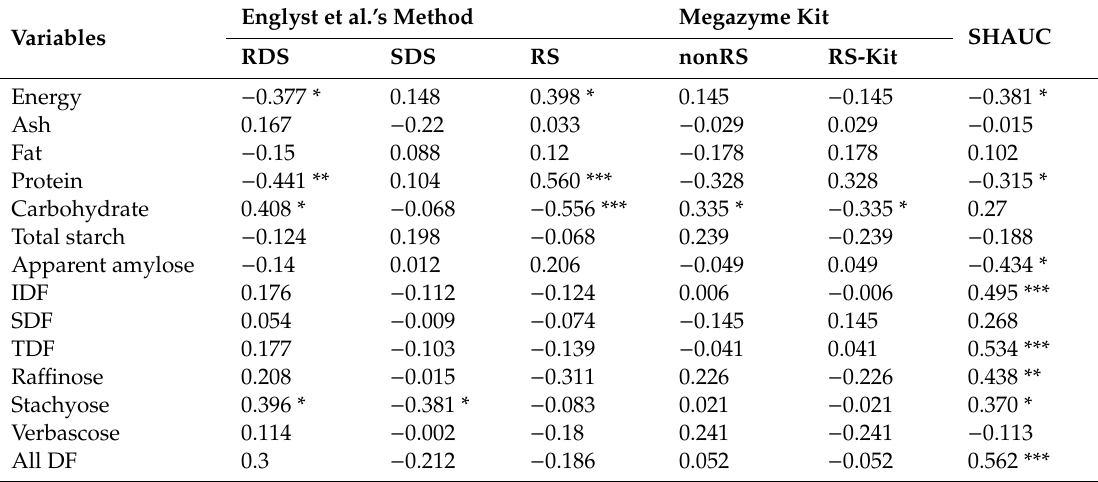
Table 5. Pearson’s correlation coe ffi cients ( r ) between chemical compositions and starch nutritional parameters of cooked